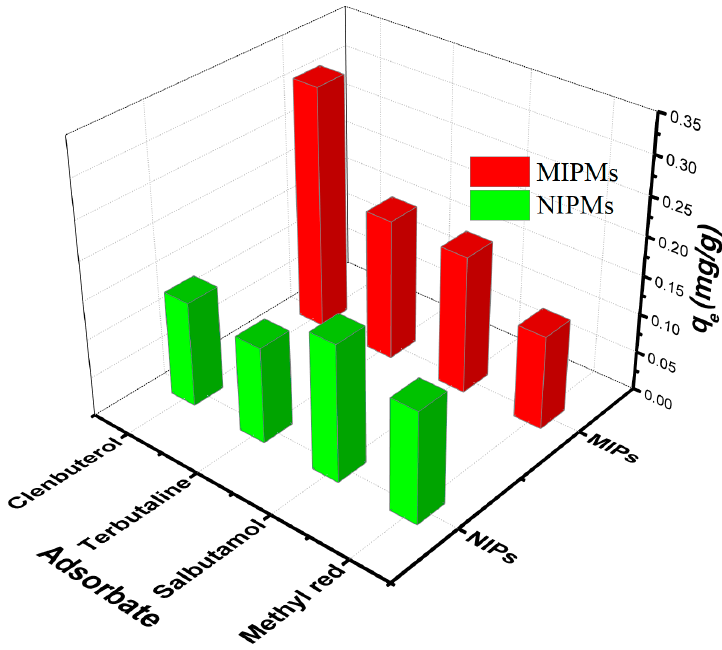
Figure 10. Selective separation of clenbuterol by the MIPMs and NIPMs from a mixture containing different competing organic species with high structural similarities to clenbuterol, including terbutaline, salbutamol, and methyl red.